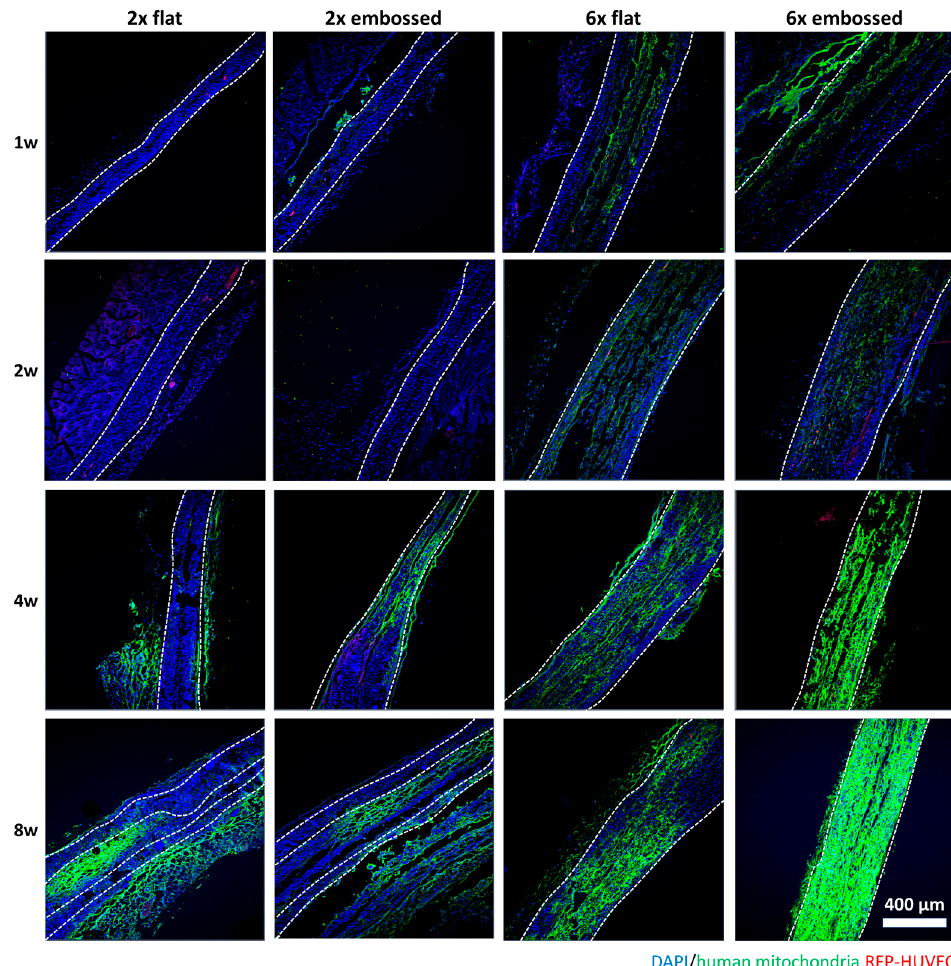
Figure 5. Immunofluorescence images showing differences in human mitochondria expression in cross-sections of experimental groups at one, two, four, and eight weeks. Dashed lines indicate edge of transplanted embossed sheets. Green: human mitochondria, red: HUVEC, blue: DAPI.